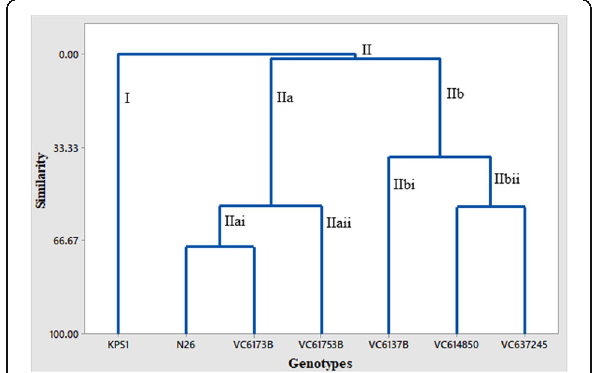
Fig. 1 Neighbor joining dendogram showing morphological diversity of green gram